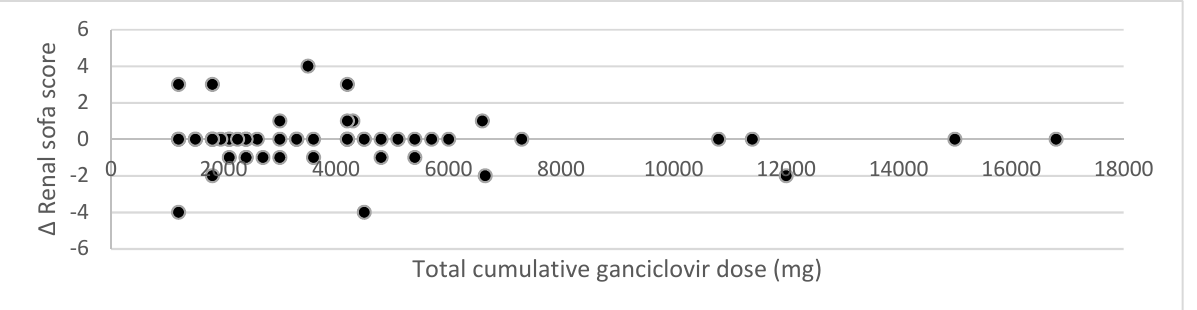
Figure 3. Impact of cumulative ganciclovir dose on the change in RIFLE score.